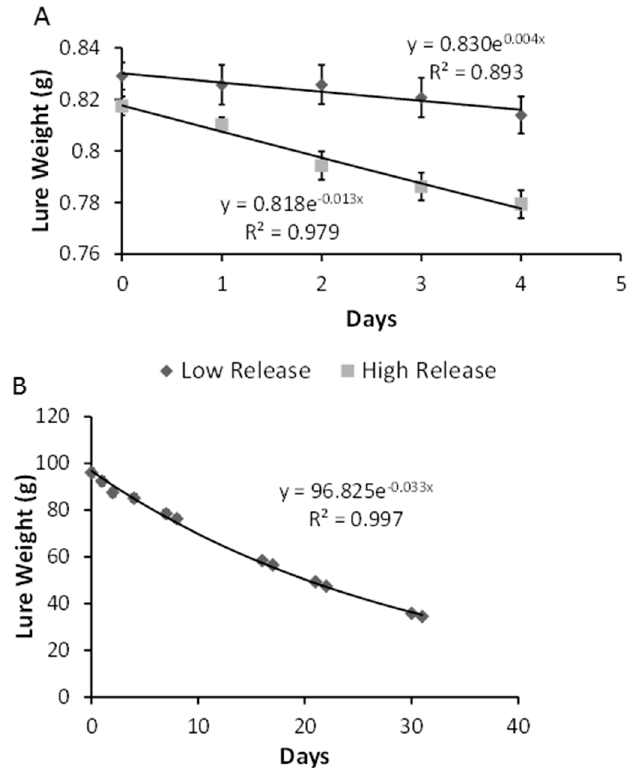
Figure 4. Exponential decay curves for botanical oil dispensers. Laboratory fir oil dispensers with (squares) and without (diamonds) a hole drilled into the lid ( A ); High release fir oil dispensers used in field trials (2013 only) ( B ).